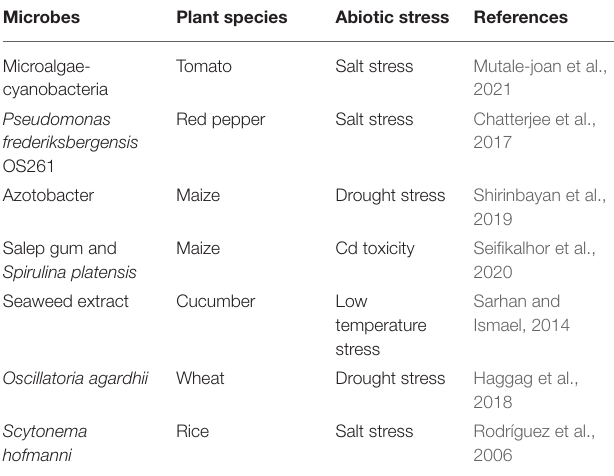
TABLE 2 | Studies on plant microbe interaction and their adverse climatic